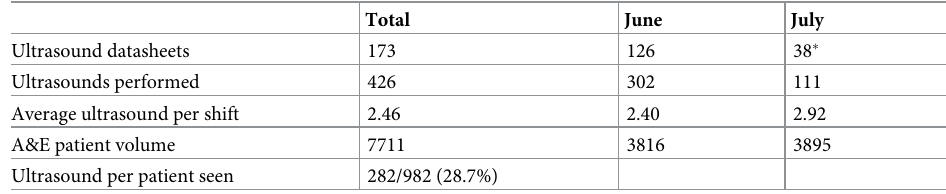
Table 1. Overall